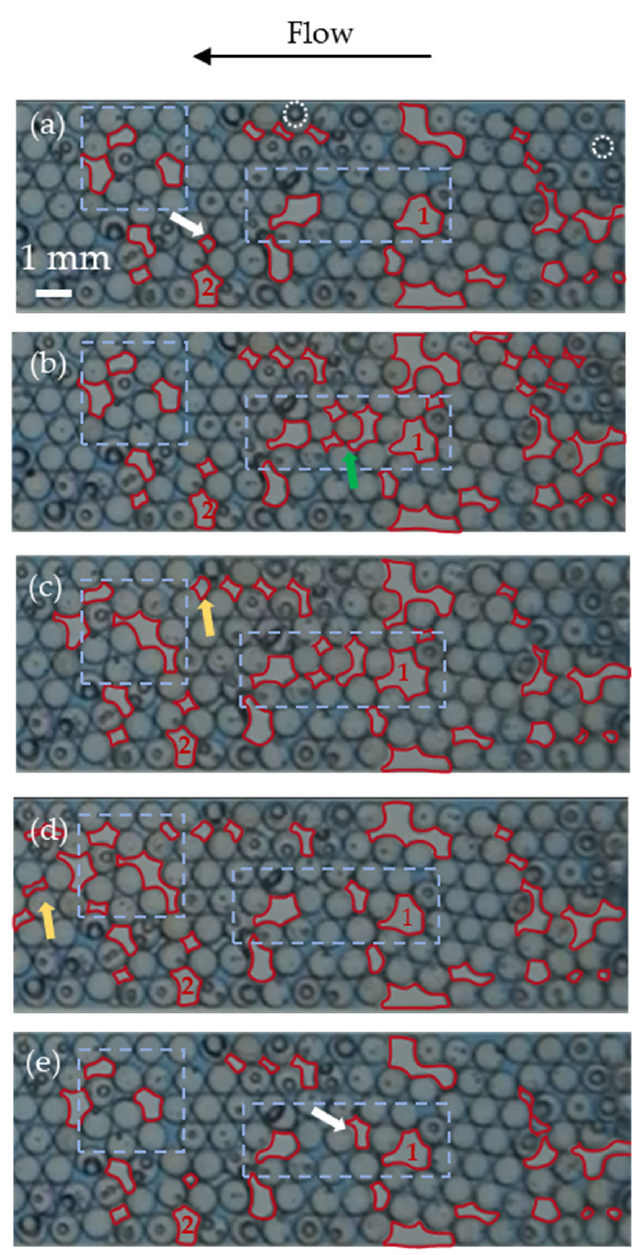
Figure 5. Images of porous medium microchannel taken during bubble transport experiment under q l = 0.6 mL/min and q a = 0.08 mL/min in 0.8 mm height microchannel (Exp. No. 9). these five images were taken at ( a ) t = 2:57 min, ( b ) t = 2:59 min, ( c ) t = 3:01 min, ( d ) t = 3:03 min, and ( e ) t = 3:05 min. The bubble started to enter the channel at ( b ) time point. The black arrow at top indicates the flow direction. The red outlines represent the air phase area. The white arrows and white dashed circle indicate the bubble formed by snap-off; the green arrow indicate the bubble formed by leave-behind. The yellow arrows indicate the small bubbles generated in situ where the incoming bubble moving through. The area enclosed by light blue dashed squares indicates where the pattern of bubble displacement can be